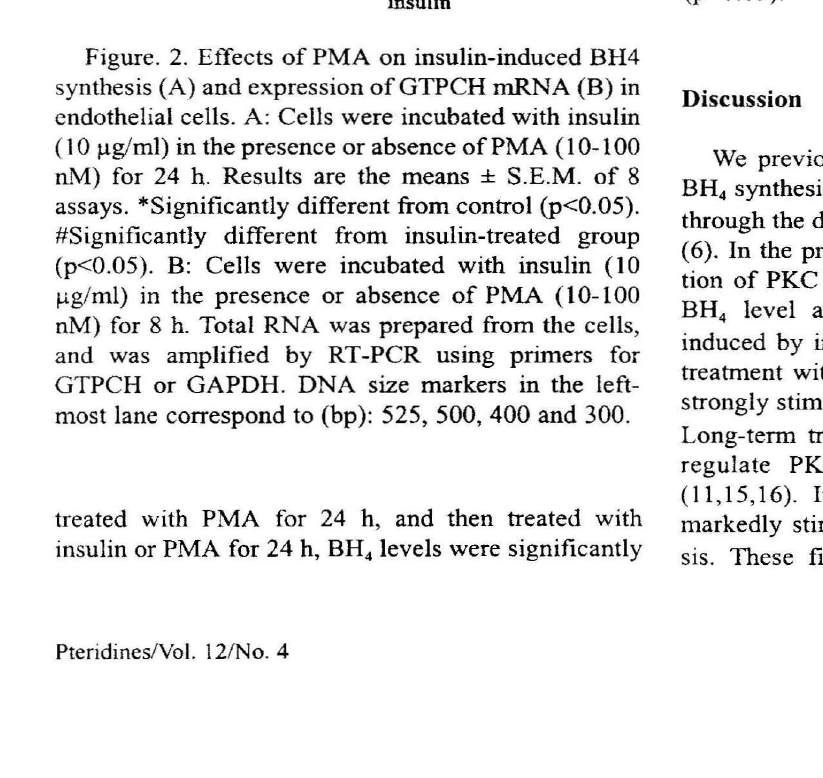
Figure. 3. Effects of pretreatment with PMA for 24 h on insulin-induced BH4 synthesis in endothelial cells. Cells were pretreated with PMA (100 nM) for 24 h, and then incubated with insulin (10 Ilg/ml) in the absence or presence of Pt-.tA, (l00 nM) for 24